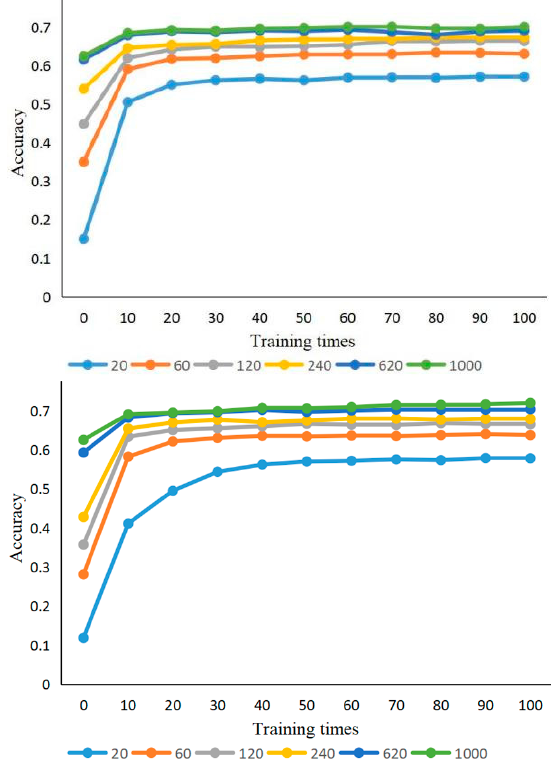
Figure 10. Experimental results when using one fully connected layer.